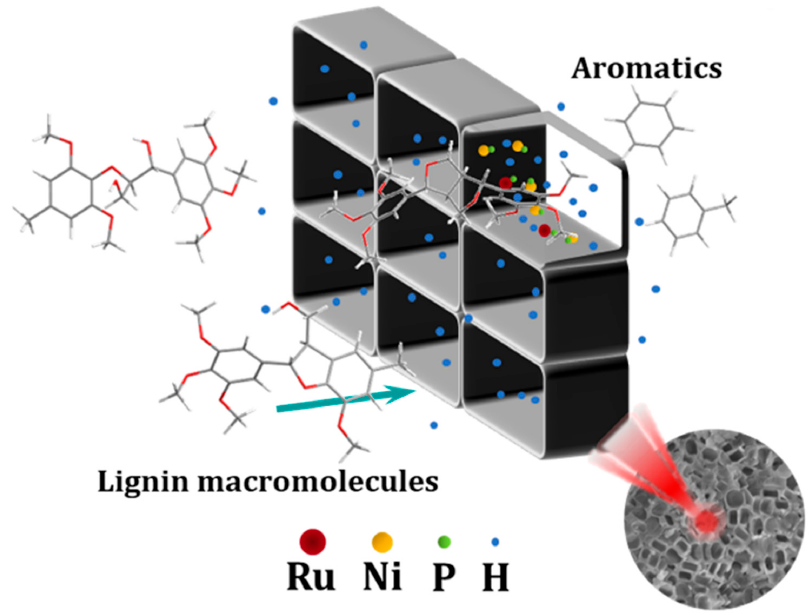
Figure 6. Schematic illustration of hydrogenolysis reactivity under a pore confined-like effect.